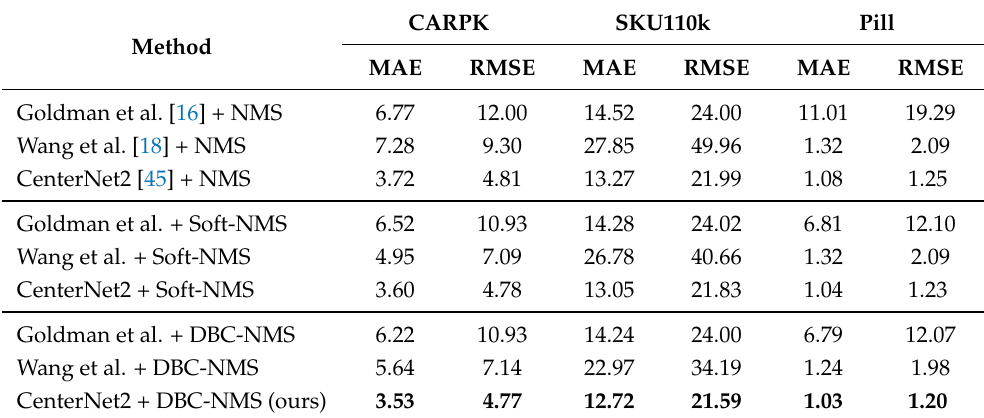
Table 3. Performance of DBC-NMS.